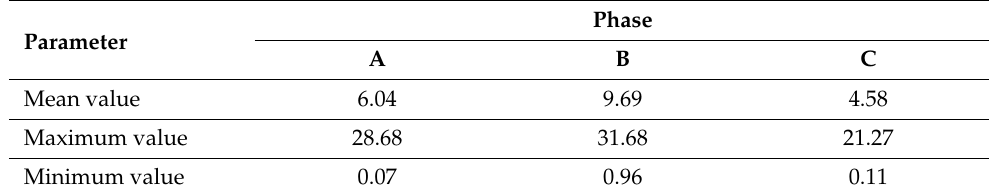
Table 7. Results of calculating total harmonic distortions at 6 kV buses of TS2.